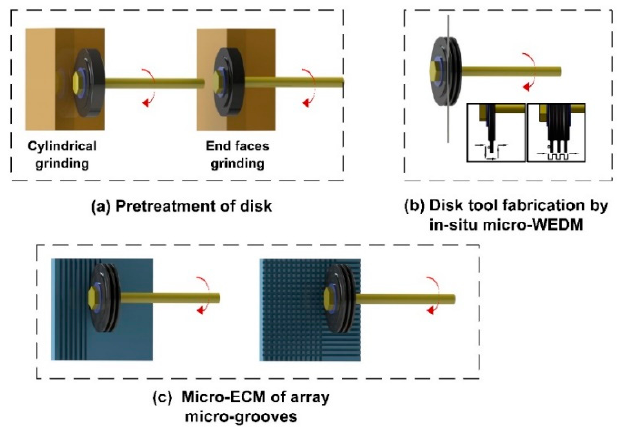
Figure 2. The schematic illustration of the primary fabrication processes that array micro-grooves are obtained by disk tool fabrication and in-situ micro-ECM. ( a ) Pretreatment of disk. ( b ) Disk tool fabrication by in-situ micro-WEDM. ( c ) Micro-ECM of array micro-grooves.